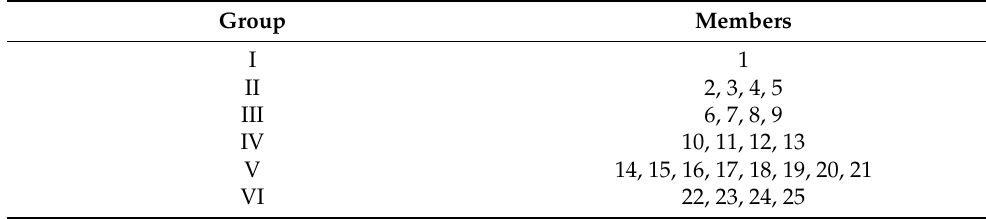
Table 4. Group membership for the truss structure.